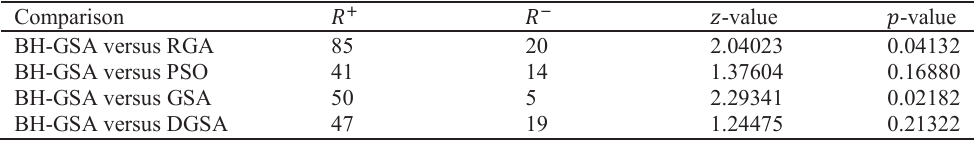
Table 8. Wilcoxon signed ranks test results for multimodal test functions of set